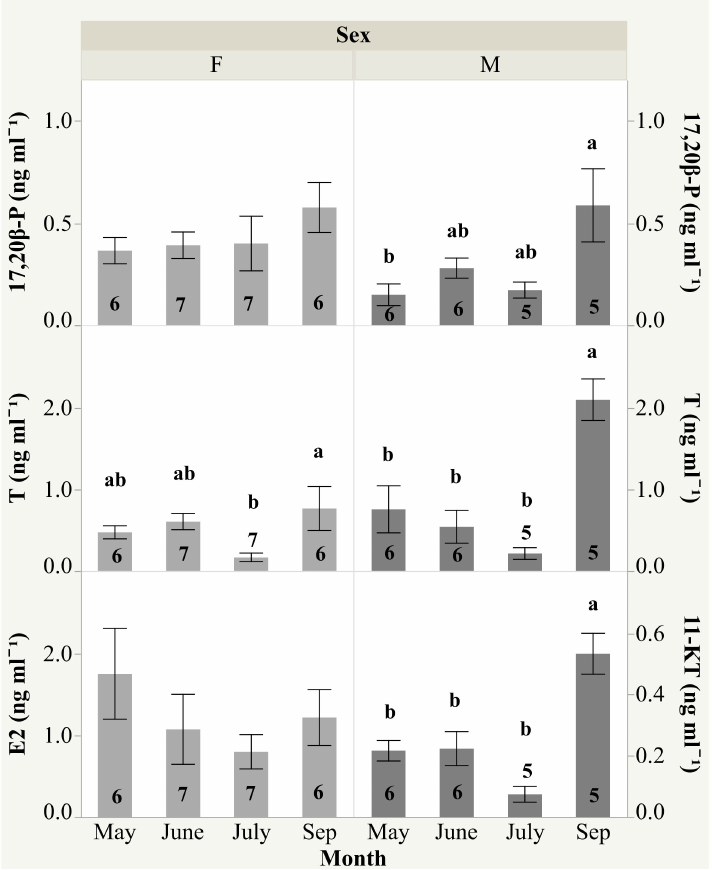
Figure 9. Mean ( ± SEM) plasma levels of 17 β -estradiol (E2), T and 17,20 β -dihydroxy-4-pregnen-3-one (17,20 β -P) in greater amberjack females (F) and of 11-keto testosterone (11-KT), testosterone (T) and 17,20 β -P in males (M) at different times during the reproductive season. Different letters indicate significant differences ( p <